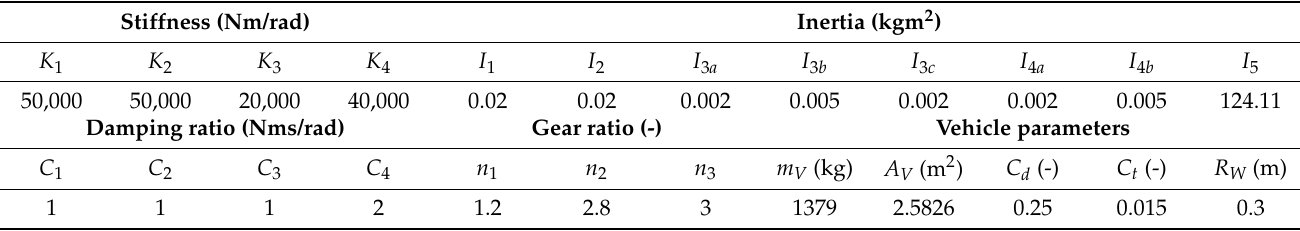
Table 1. Parameters of the powertrain and